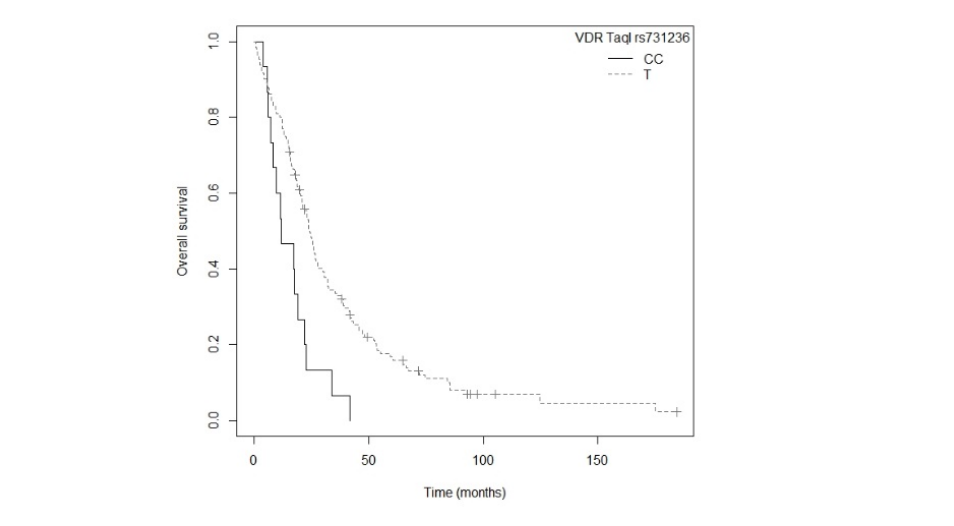
Figure 5. Kaplan–Meier plot of overall survival curves with the C allele of the CYP24A1 rs6068816 gene polymorphism in the non-resected NSCLC subgroup.